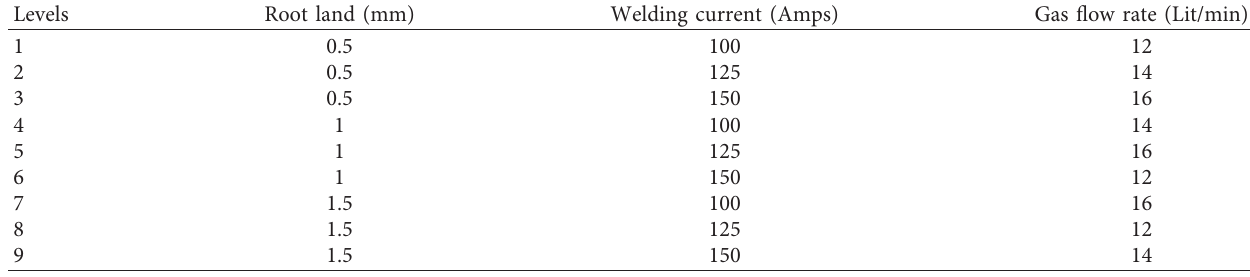
Table 1: Parameters for modelling and experimentation.